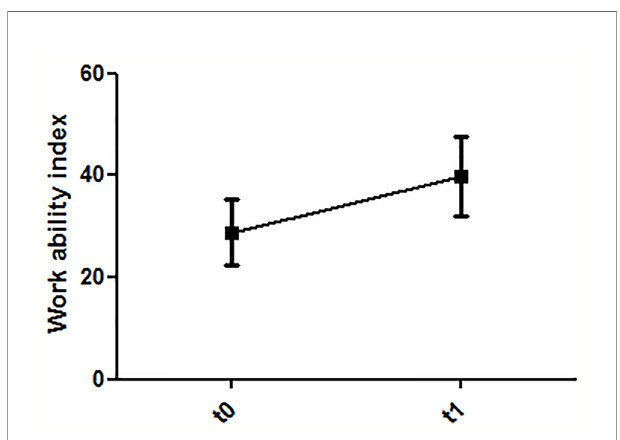
FIGURE 5 | Dynamics of work ability (T0: before fi rst treatment session; T1: after last